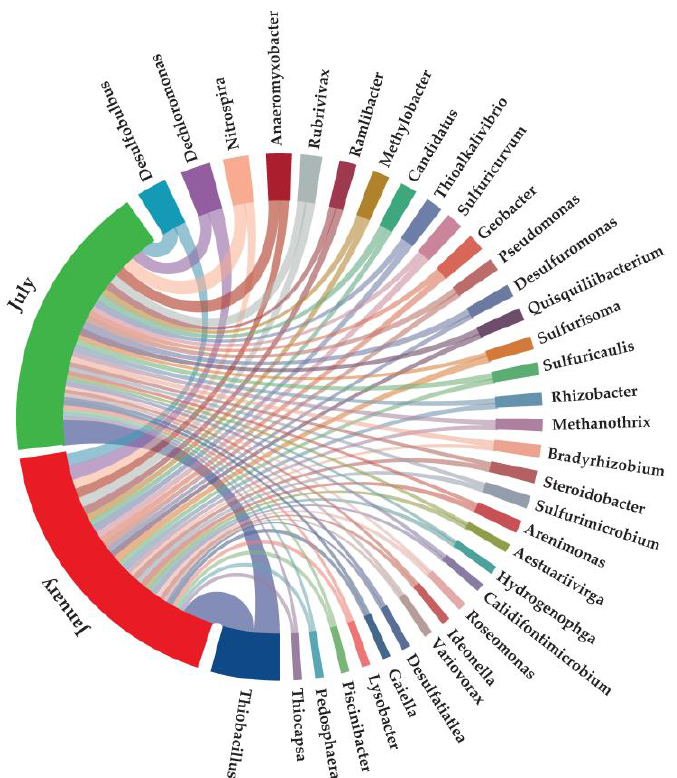
Figure 4. Chord diagram of nitrogen-associated microbial community composition at the genus level.